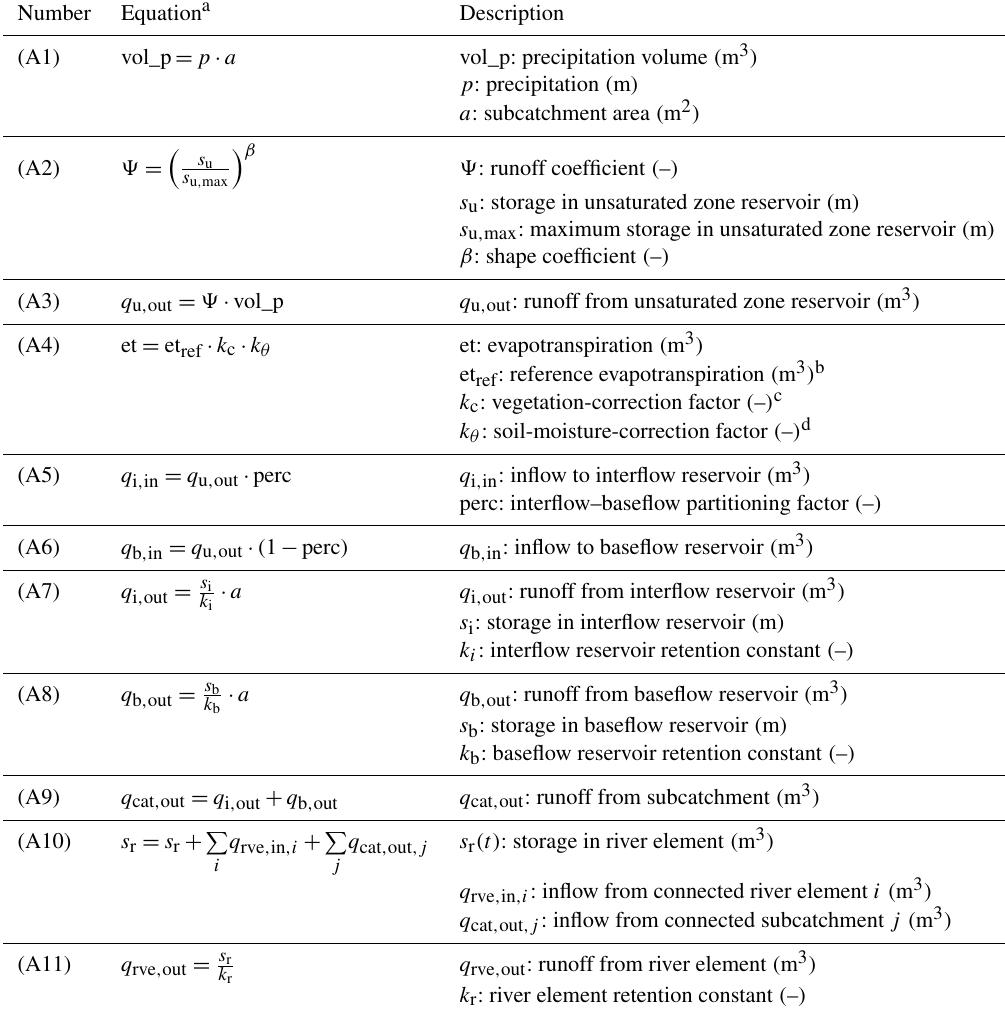
Table A1. SHM model equations and